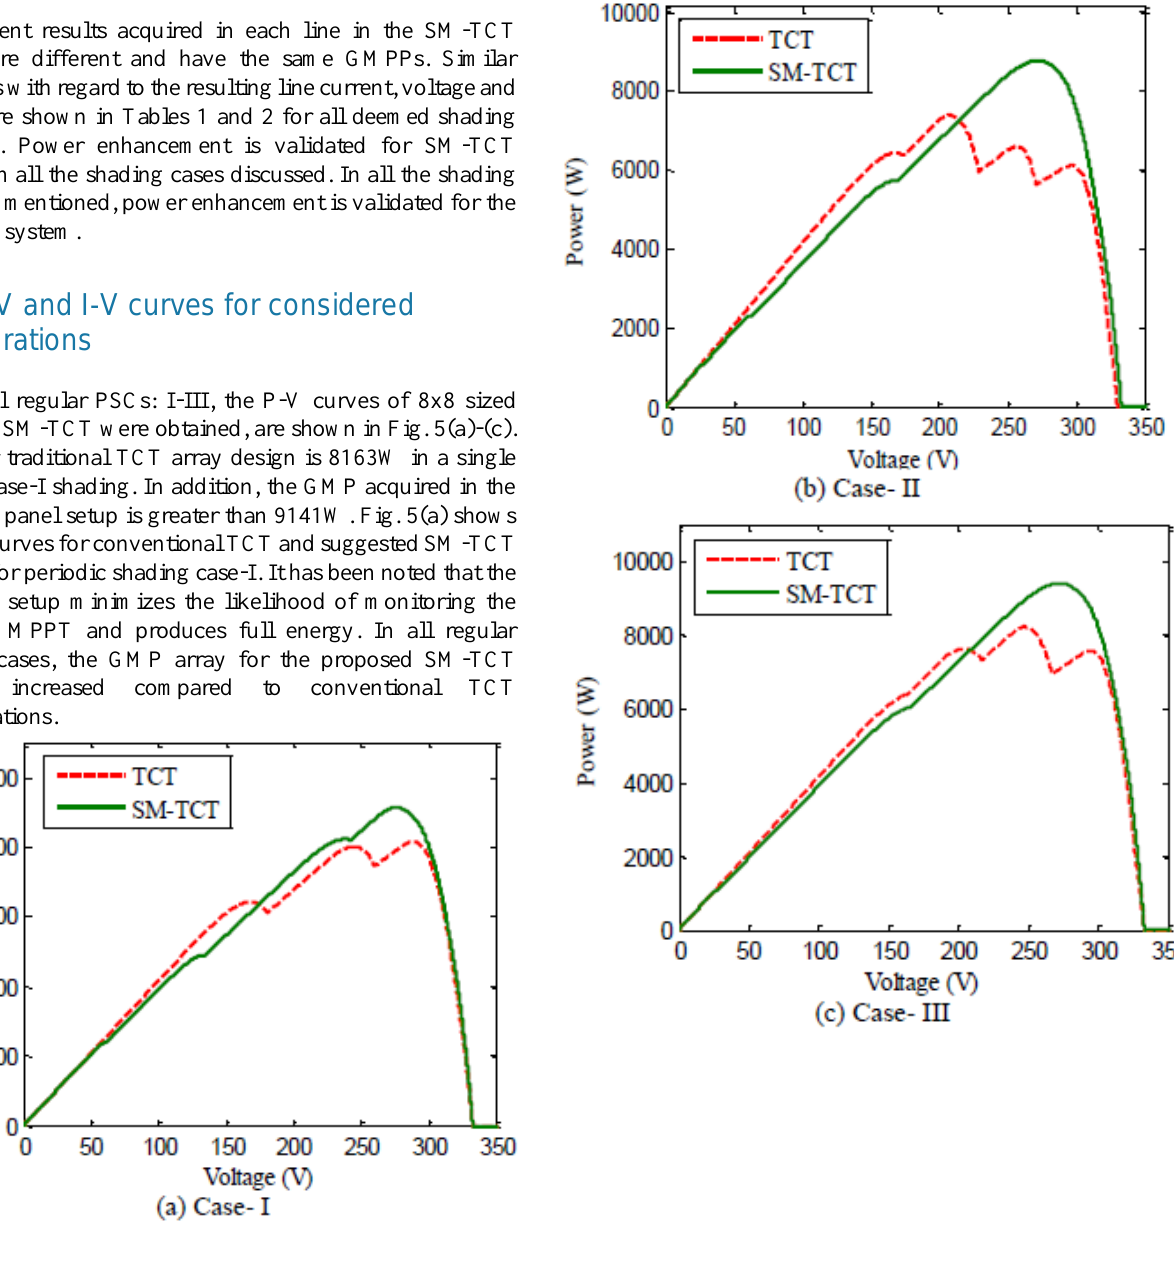
Figure 5(a)-(c). P–V curves for regular shading test cases: I- III